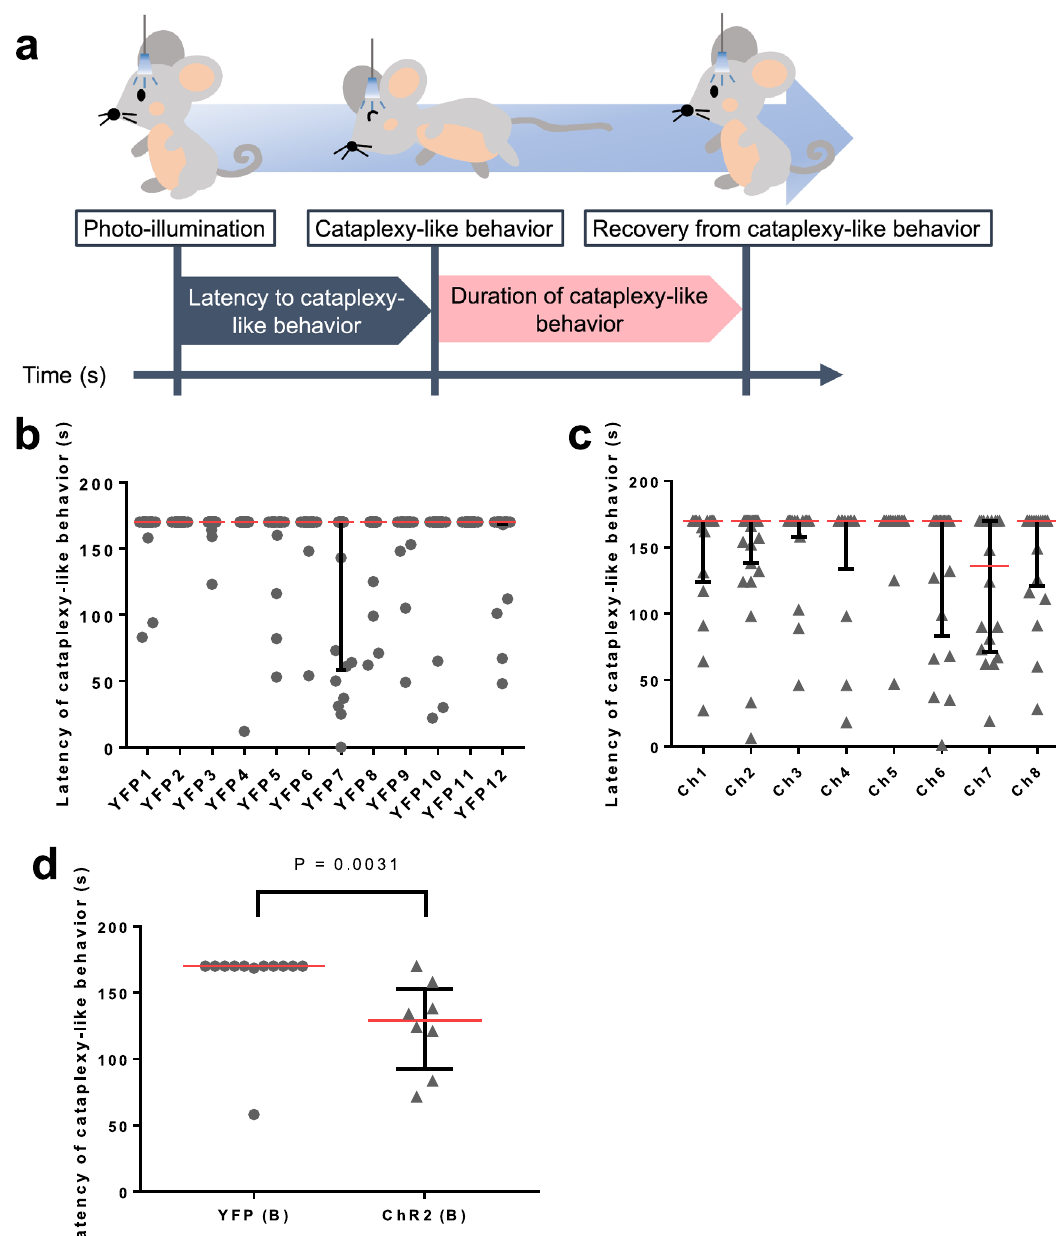
Figure 2. Latency of photo-illumination-induced cataplexy-like behavior. ( a ) Schematic explanation of the latency and duration of cataplexy-like behavior by photo-illumination on the rostral NAc shell. When cataplexy- like behavior was observed during photo-illumination, we call it “photo-illumination-induced cataplexy-like behavior." Otherwise, the cataplexy-like behavior was defined as “spontaneous cataplexy-like behavior." The latency of photo-illumination-induced cataplexy-like behavior was defined as the time from the start of photo-illumination to cataplexy-like behavior occurrence. When photo-illumination-induced cataplexy-like behavior was not observed, the latency was defined as 170 s with blue photo-illumination and 140 s with green photo-illumination. ( b , c ) The onset latency of cataplexy-like behavior in an individual mouse by blue photo- illumination for YFP and ChR2 expressing mouse. Each dot represents a single onset latency of cataplexy-like behavior in YFP group ( b ) and ChR2 group ( c ). 20–23 illuminations were applied to one animal in YFP group ( b ). 13–27 illuminations were applied to one animal in ChR2 group ( c ). Horizontal bars represent the median (red) with 25%-interquartile values (black). ( d ) Comparison of onset latency of cataplexy-like behavior between YFP and ChR2 expressing mouse. The dots show the 25-percentile value of the onset latency of the cataplexy- like behavior by photo-illumination in each animal. The latency was significantly shorter in the ChR2 group than that in the YFP group (Mann–Whitney U test, P = 0.0031, YFP (B) n = 12, ChR2 (B) n = 8). Two animals out of 12 animals in the YFP group never showed photo-illumination-induced cataplexy-like